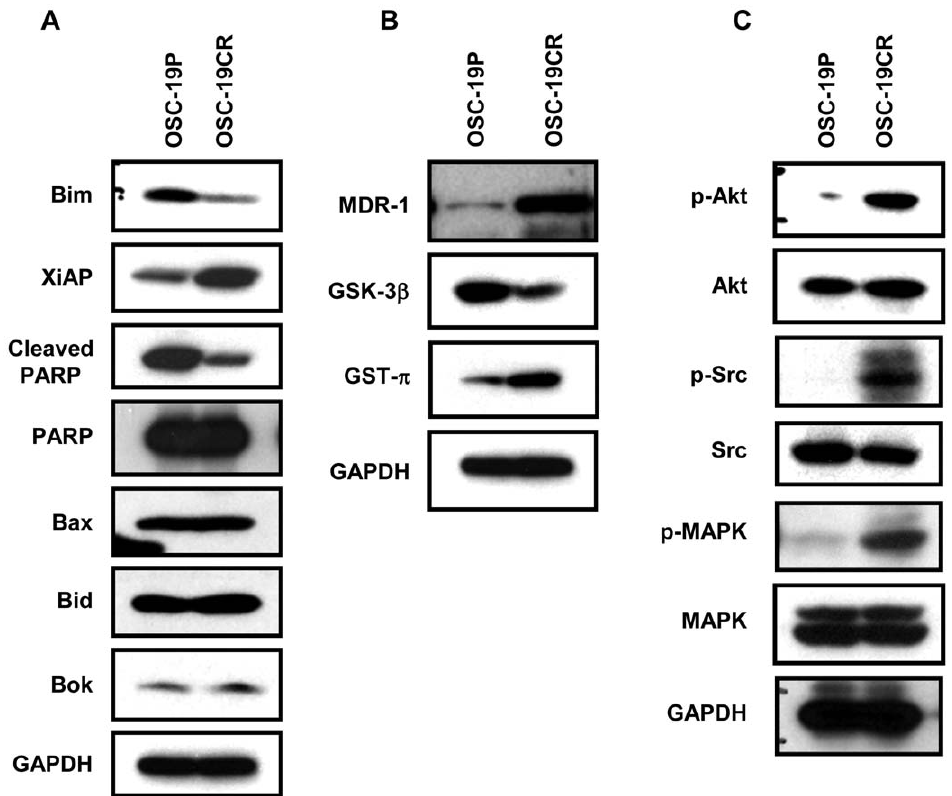
Figure 2. CDDP resistant cells modulate expression of molecules related with cell survival. A . Apoptotic molecules, B . Drug resistance- related molecules, and C . intracellular signal molecules.